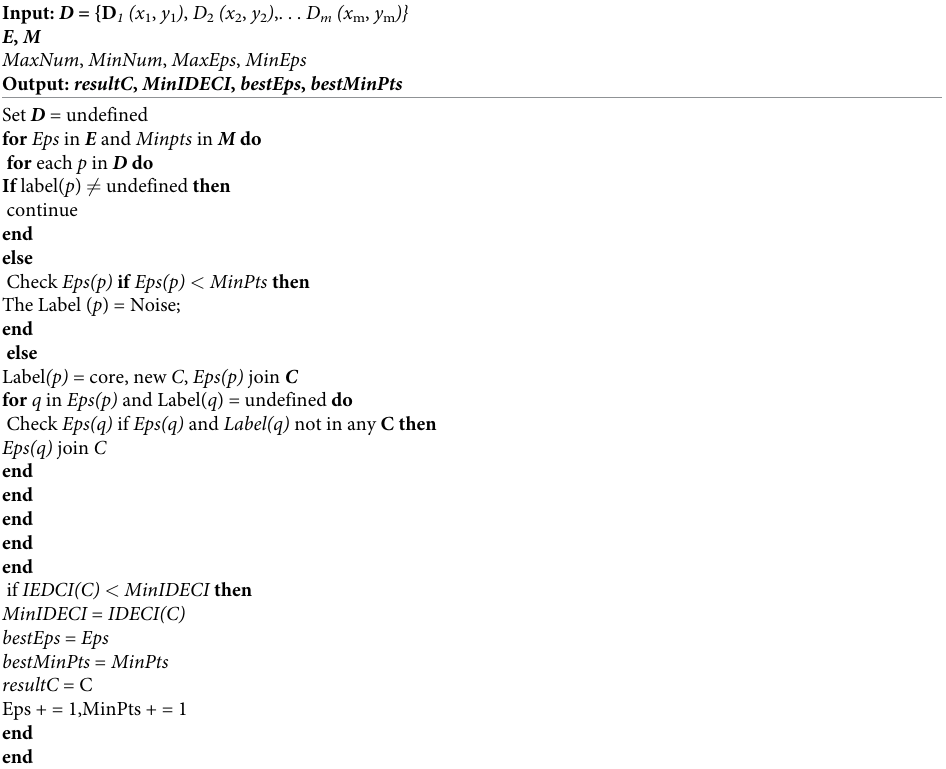
Table 1. Improved DBSCAN clustering